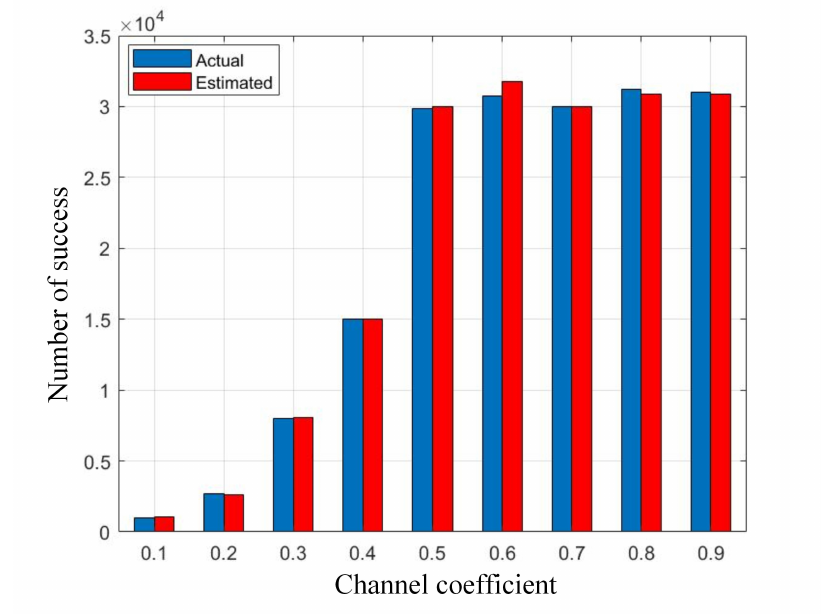
Figure 10. Number of successes vs. channel